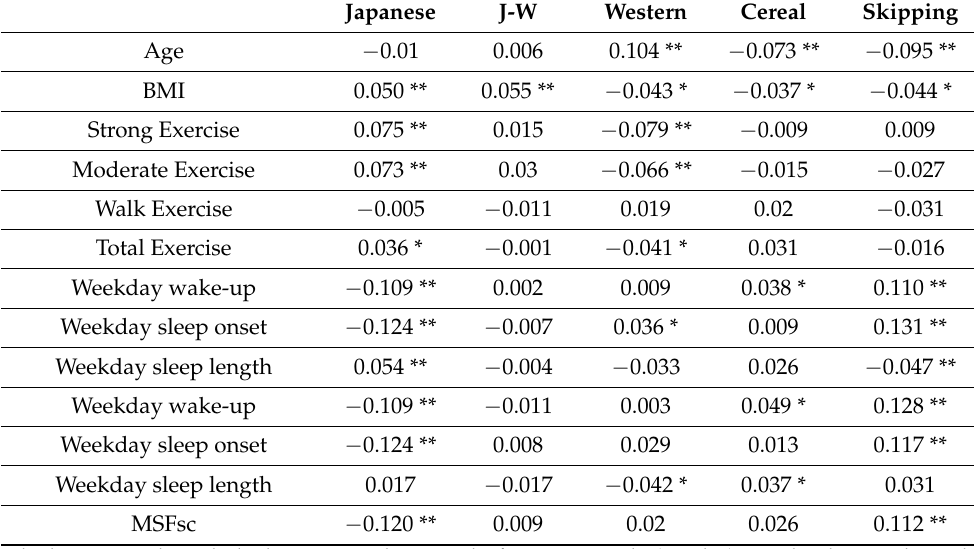
Table 2. Spearman’s correlation analysis between basic characteristics, exercise, sleep parameters, and breakfast meal